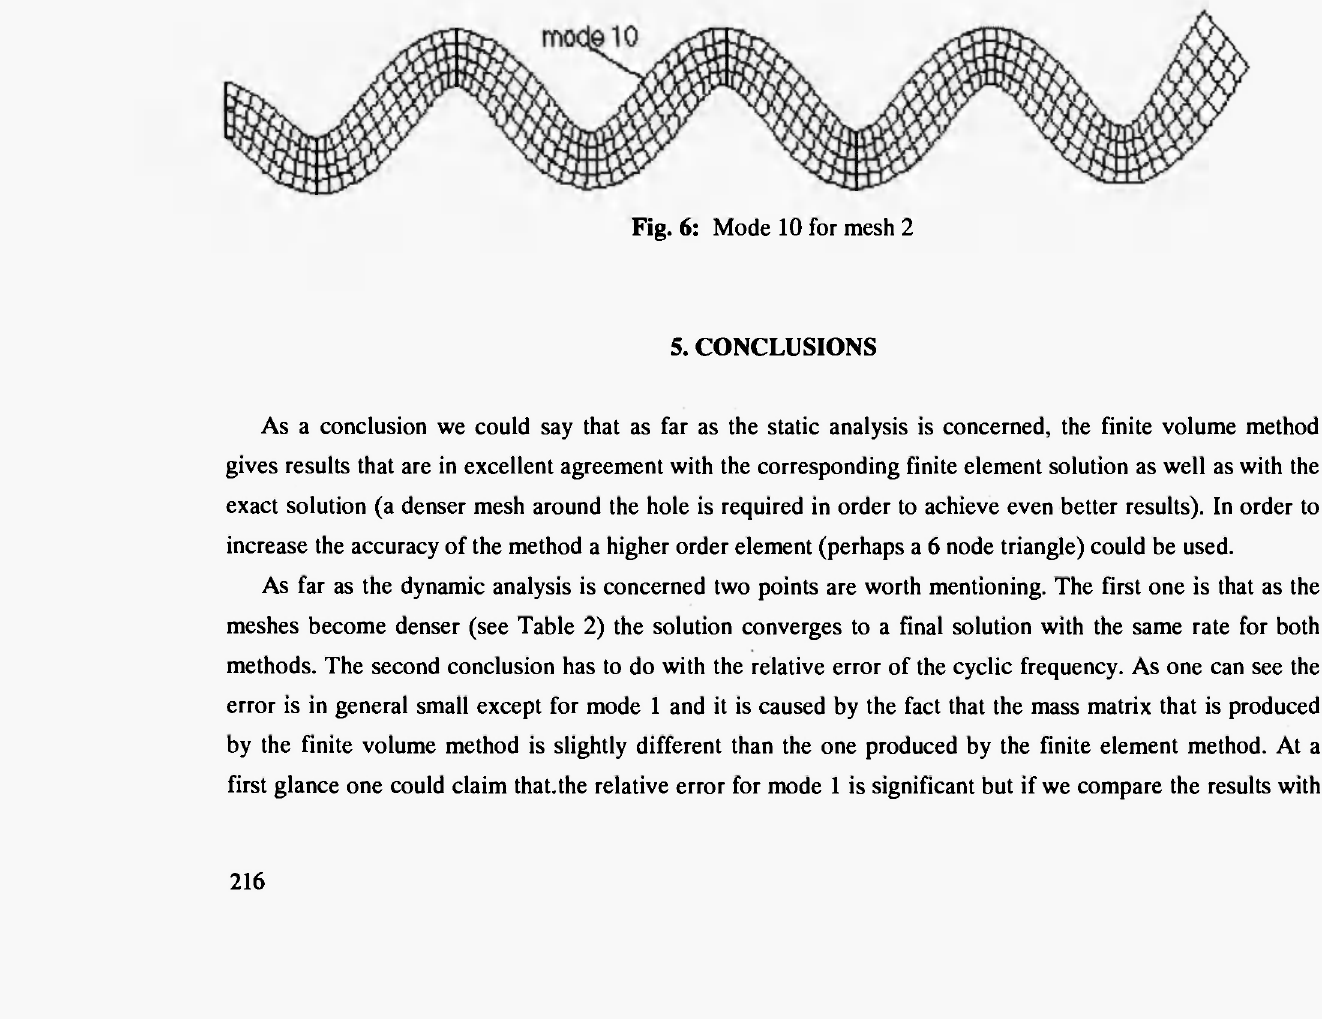
Fig. 5: Modes 1 to 9 for mesh 2